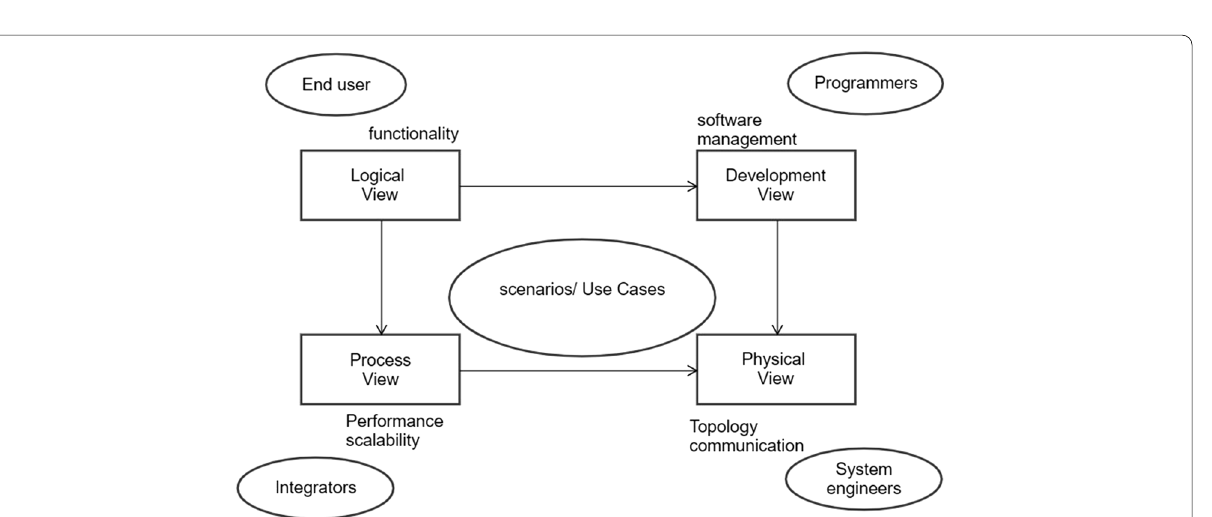
Fig. 3 4 1 model for software +